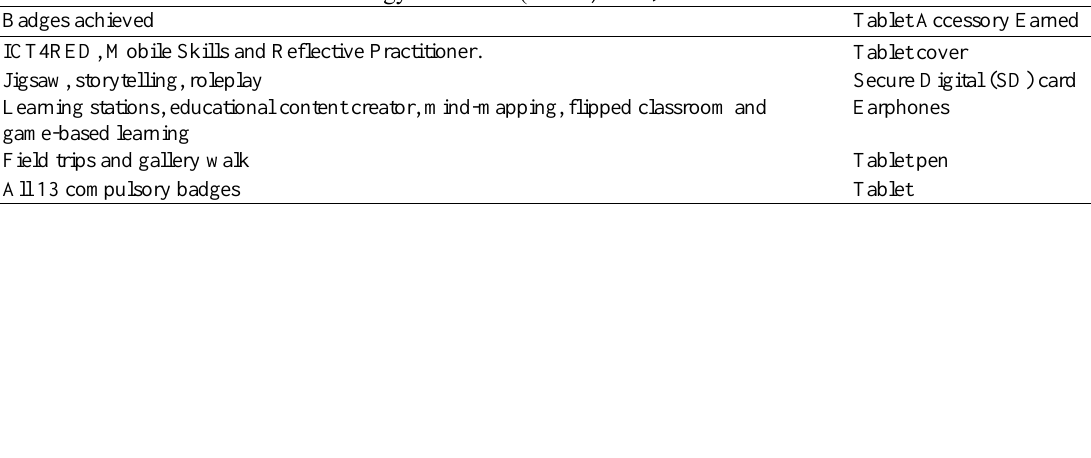
Table 5 Individual Teachers’ Technology Hardware (Botha,